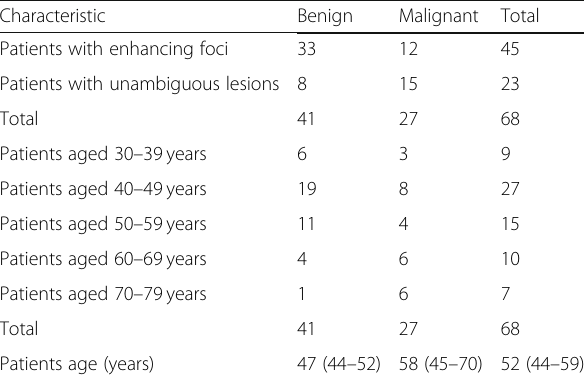
Table 2 Study population (patients with enhancing foci and with unambiguous